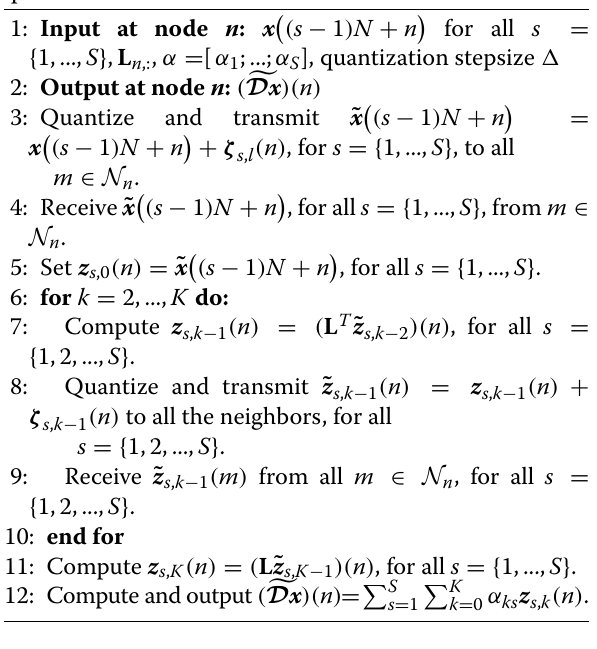
Algorithm 4 Distributed computation of D x with